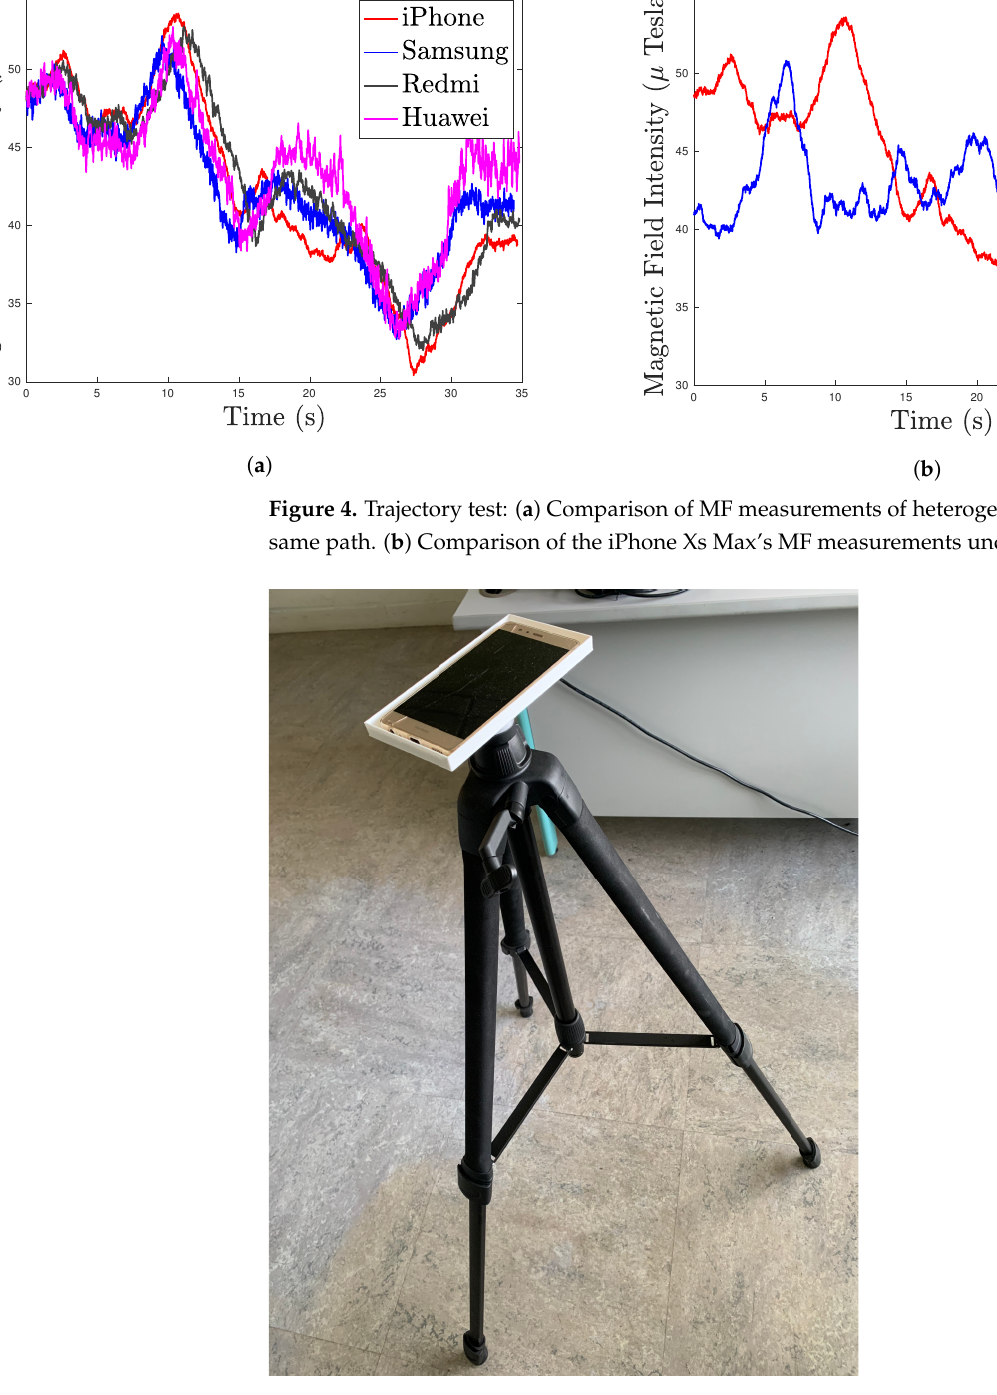
Figure 5. Rotatable and height-adjustable